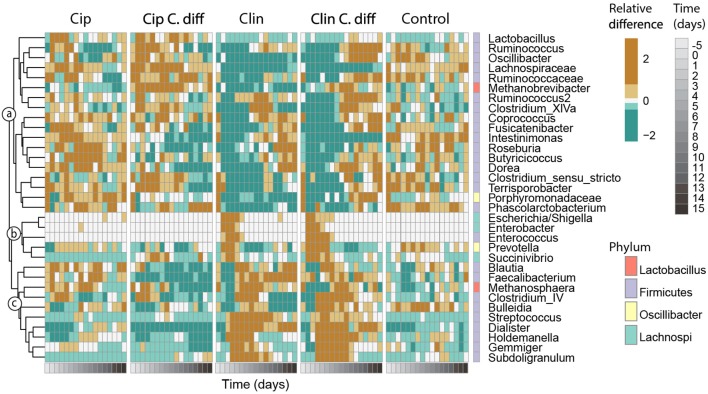
Responses of key taxa to antibiotic and C. difficile treatments. Thirty-three genera which exhibited high species scores in a principal response curve (bottom) were selected. Abundances were averaged per time point for each treatment, and centered and scaled prior to plotting. The phylum membership of each taxon is displayed on the right column, and the lowest classification of each taxon is shown on the right. Taxa were clustered into groups a–c according to their temporal response pattern using Ward's clustering method.